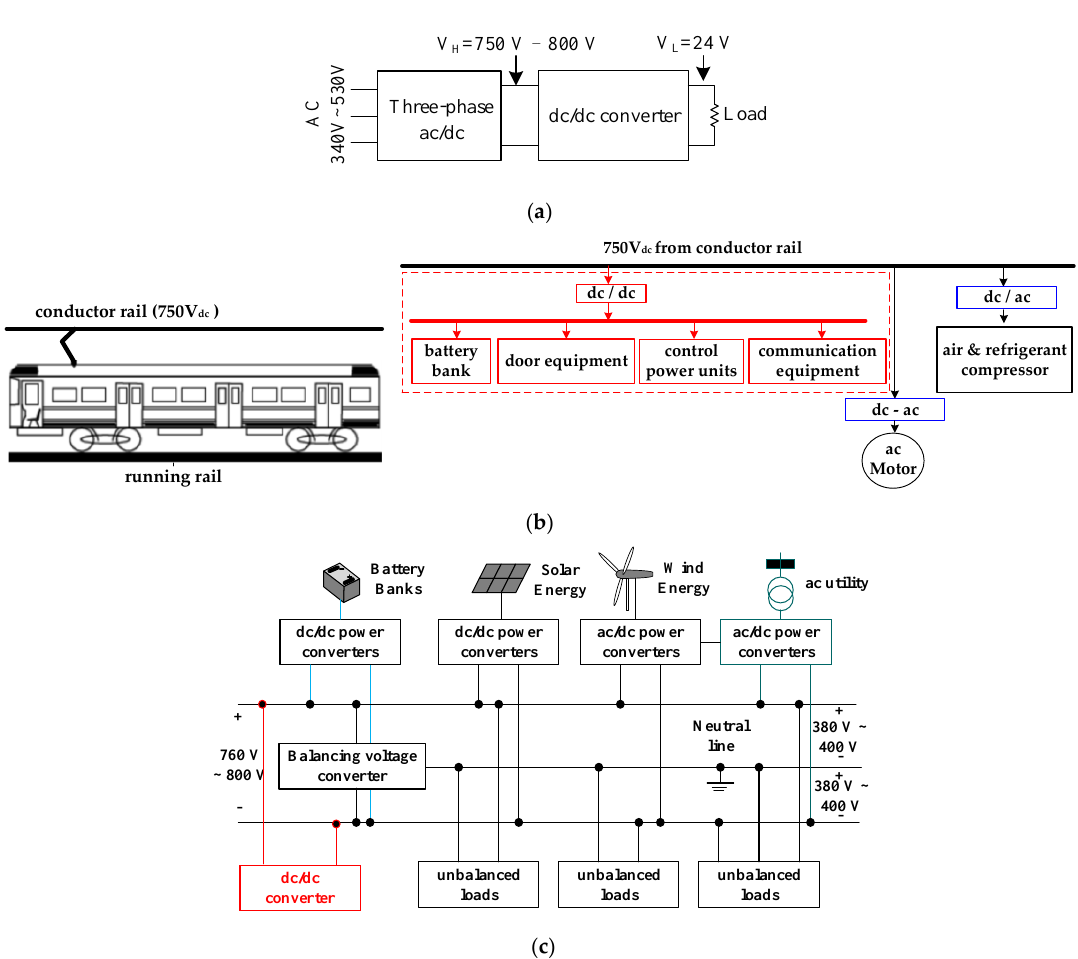
Figure 1. High-voltage dc/dc converters in ( a ) ac/dc converters, ( b ) dc light rail transportation vehicle, ( c ) dc micro-grid system with bipolar voltages.